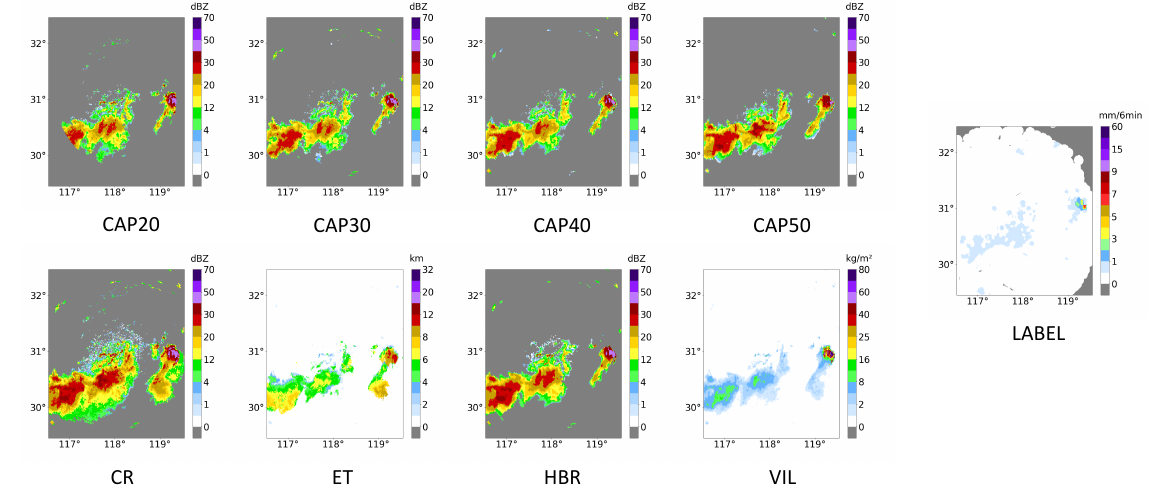
Figure 7. A visualization example of Doppler radar features and correspoding precipitation label, which comes from 4:01 Beijing Time, 14 July 2016. The left side of the figure is different channels (products) of Doppler radar, while the right side of the figure is the rainfall